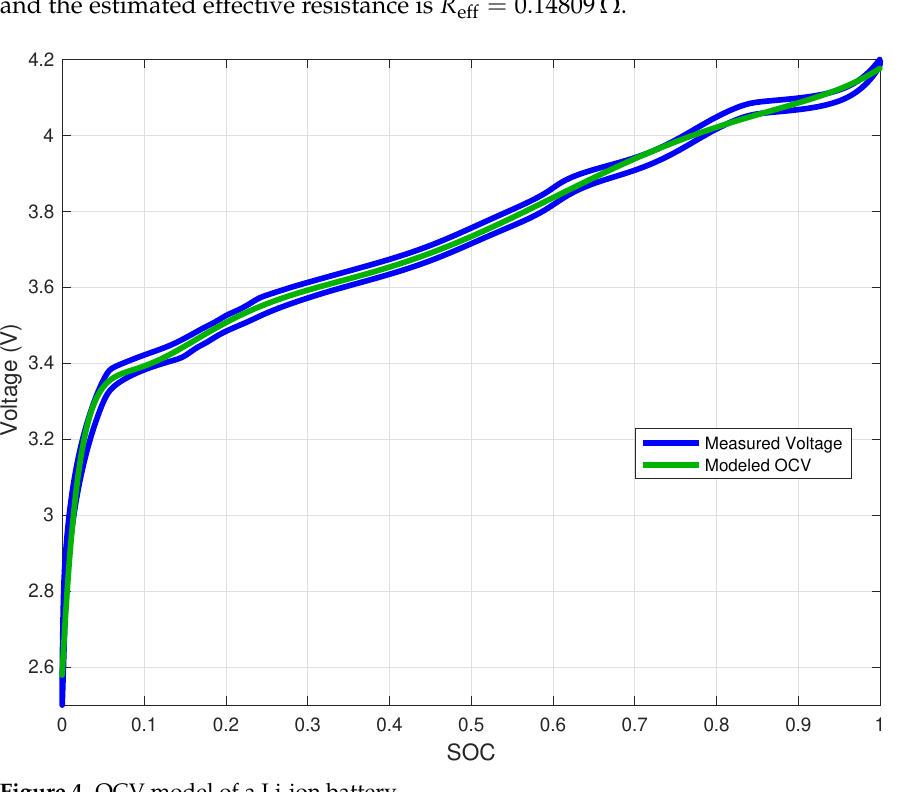
Figure 4. OCV model of a Li-ion